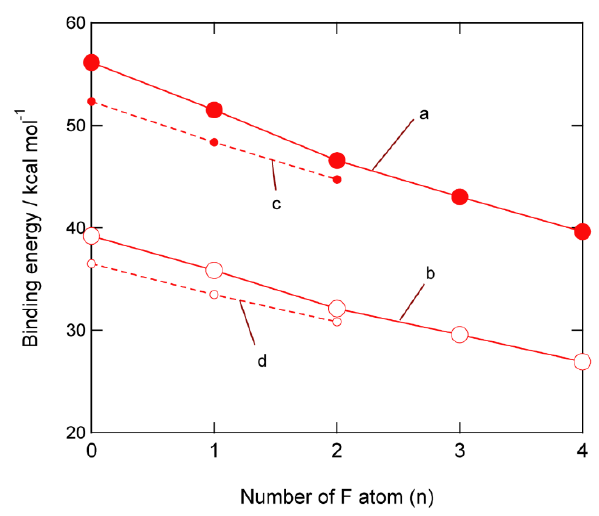
Figure 7. Binding energies in several systems plotted as a function of n, the number of F ‐ atoms. ( a ) EC ‐ Li + ; ( b ) EC ‐ Li + ‐ graphene; ( c ) VC ‐ Li + ; and ( d ) VC ‐ Li + ‐ graphene.